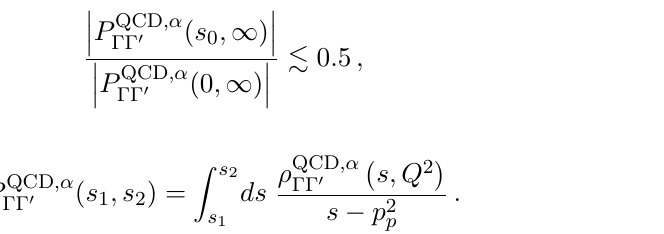
(cid:0) (cid:1) Q 2 = 2 GeV 2